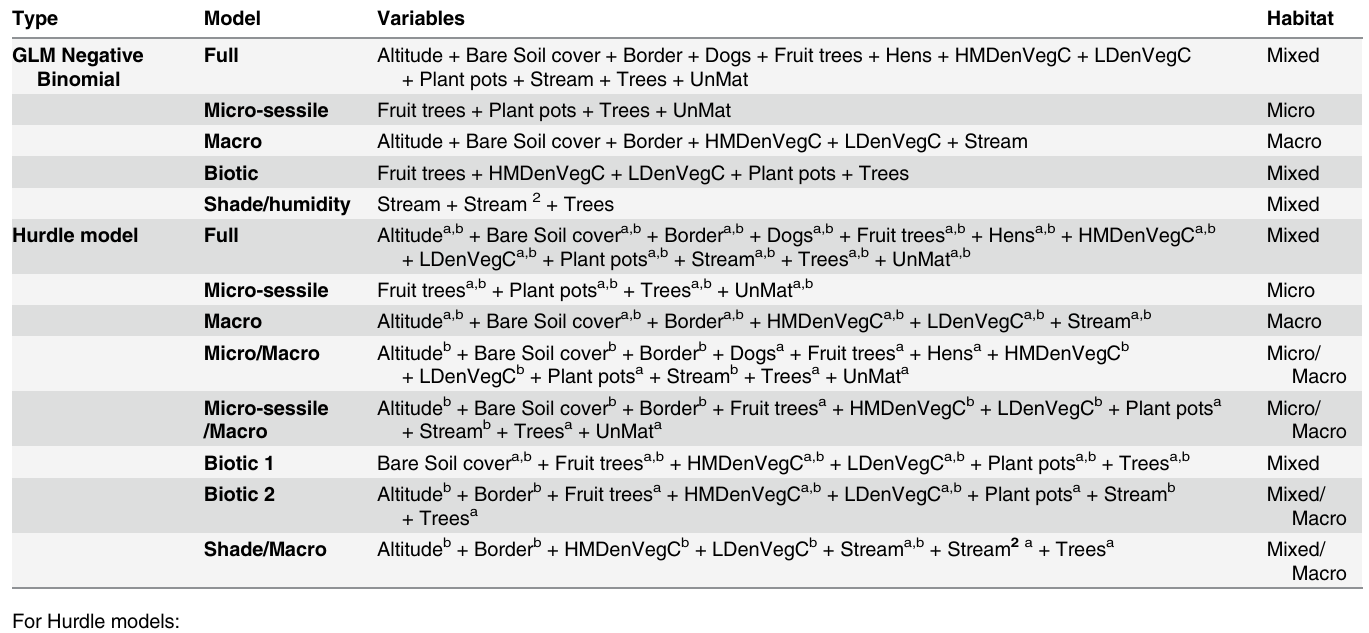
Table 2. Candidate models, variables included and